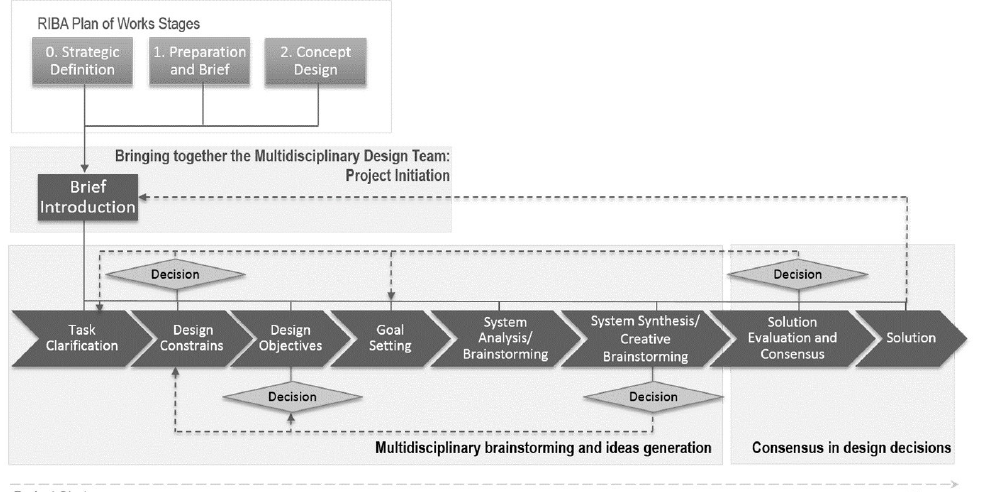
Figure 1. General process for solution finding in Leon and Laing